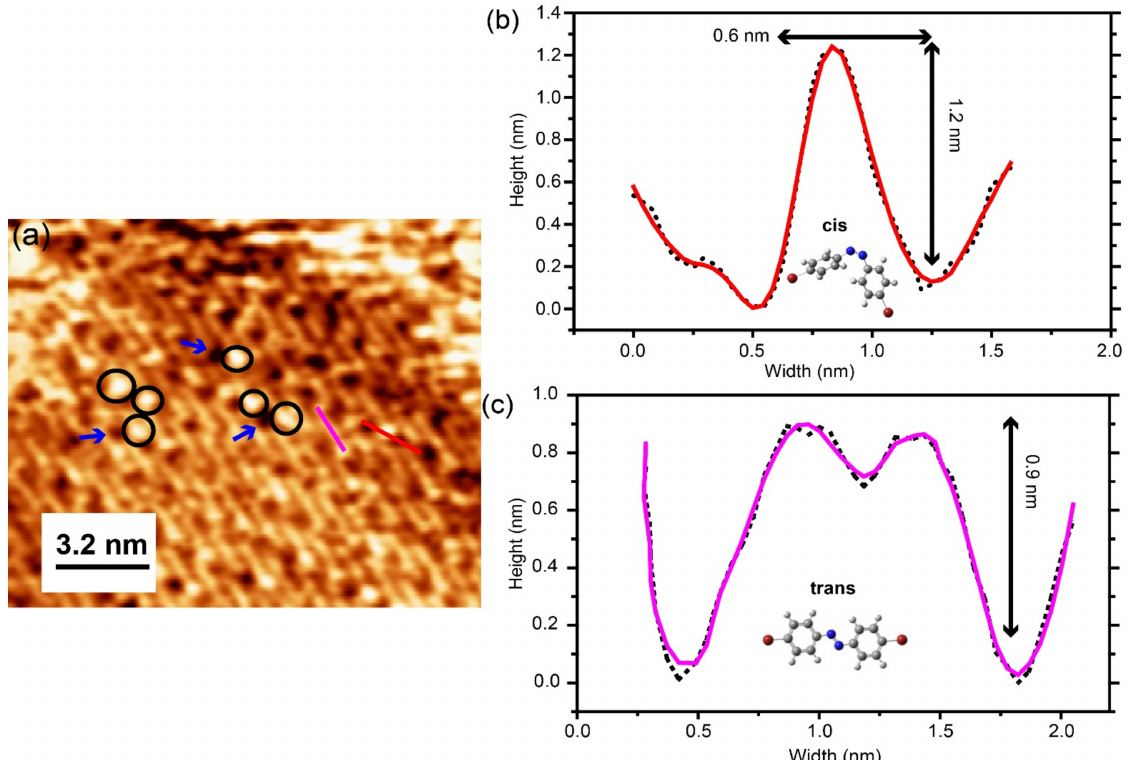
Figure 4. ( a ) STM topographic image of the photo-isomerization reaction of azo/Au(111) after the exposure to 365 nm UV light. Areas highlighted areas in circles show the cis-isomer states. Arrows show the vacancies. ( b ) Height profile of cis-isomers, measured along the red line in ( a ). Inset shows the